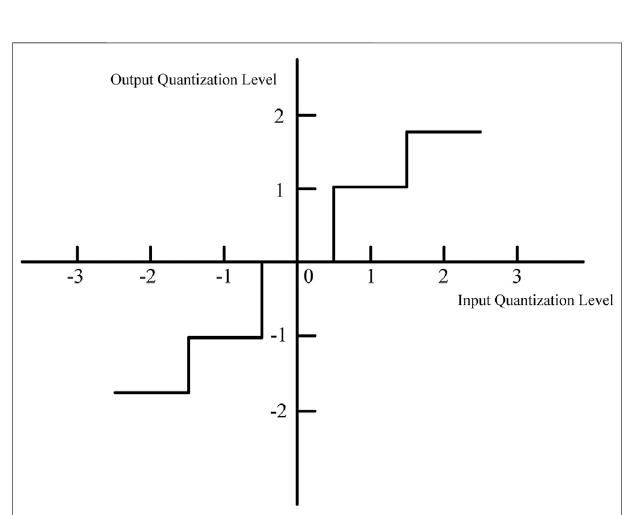
FIGURE 5 | Characteristic curve of fl at-type uniform